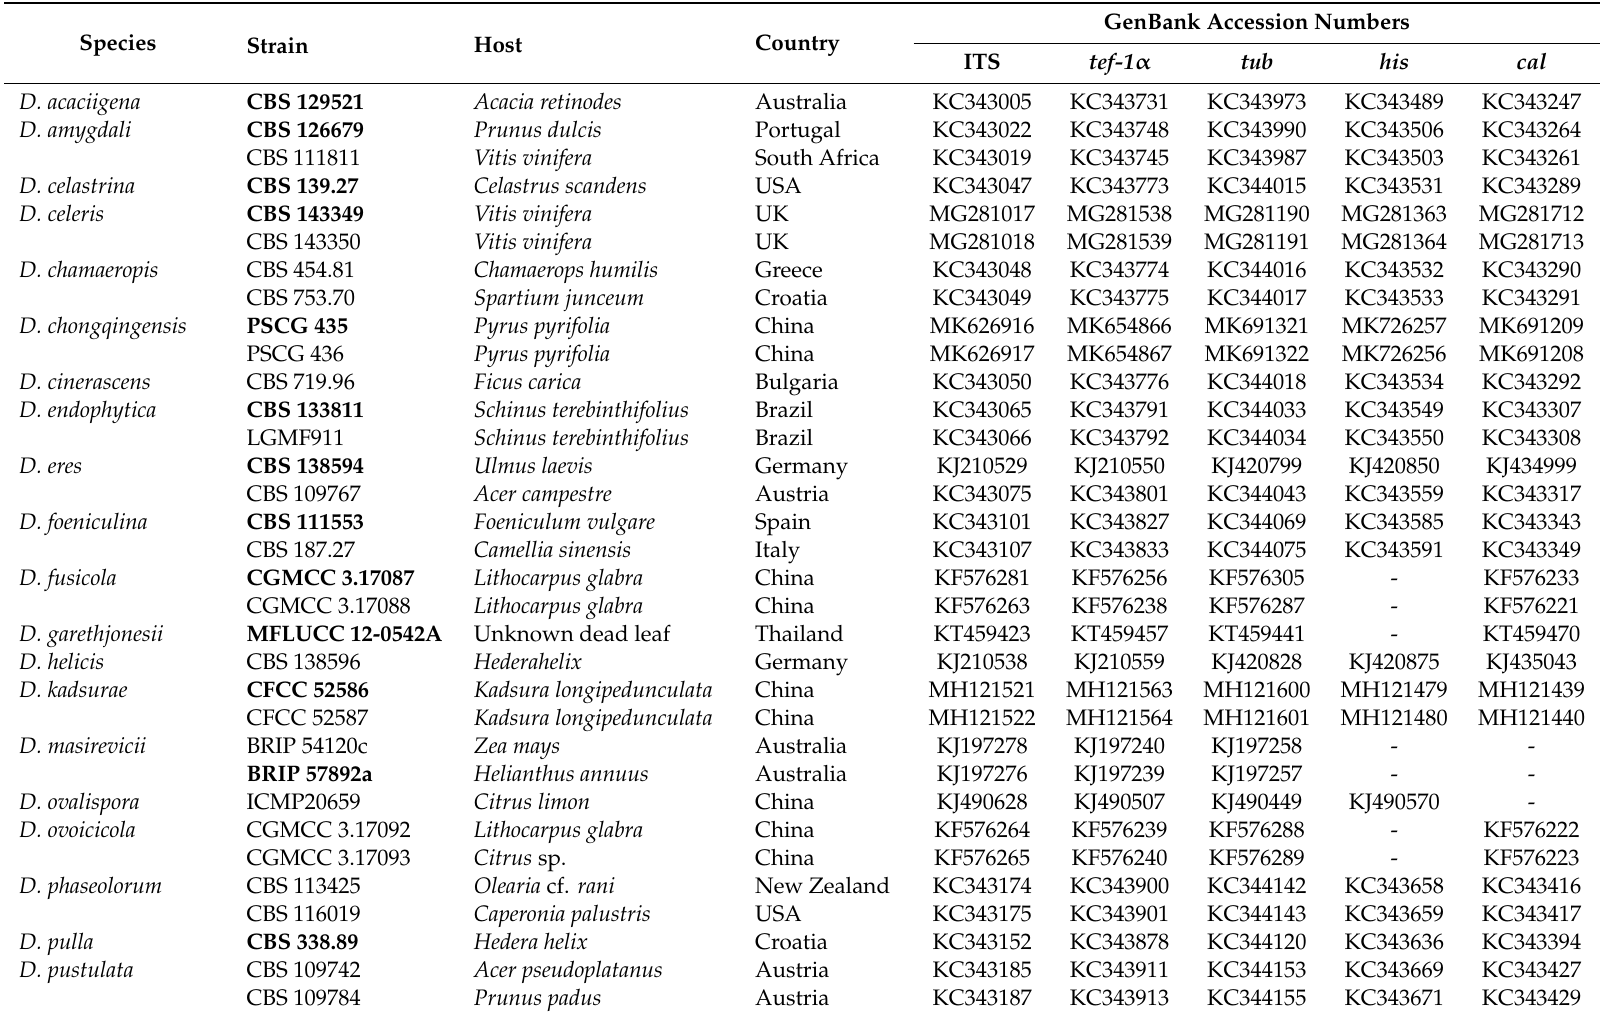
Table 2. Additional Diaporthe species used in the phylogenetic